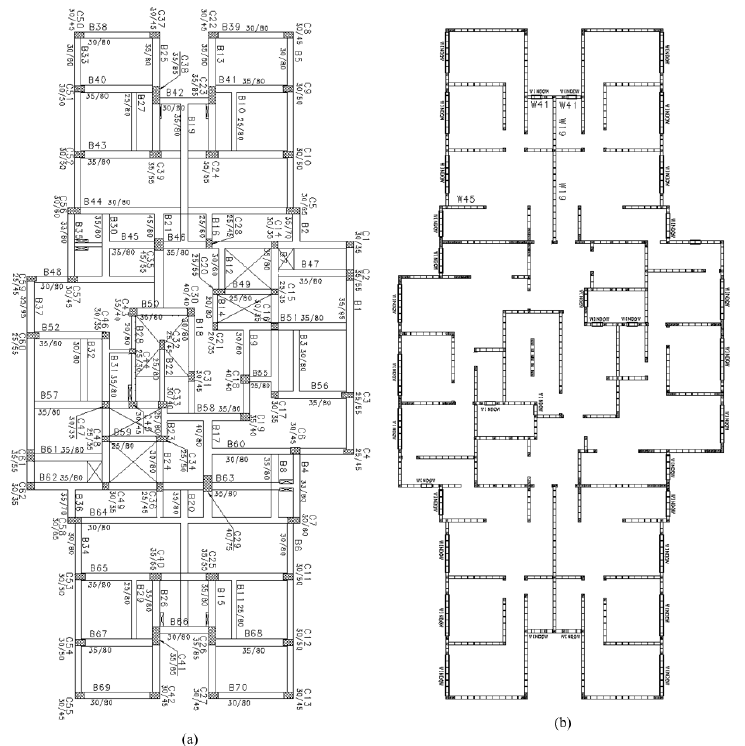
Figure 5. Building structure: (a) Reinforced concrete support structure; (b) Structural masonry first